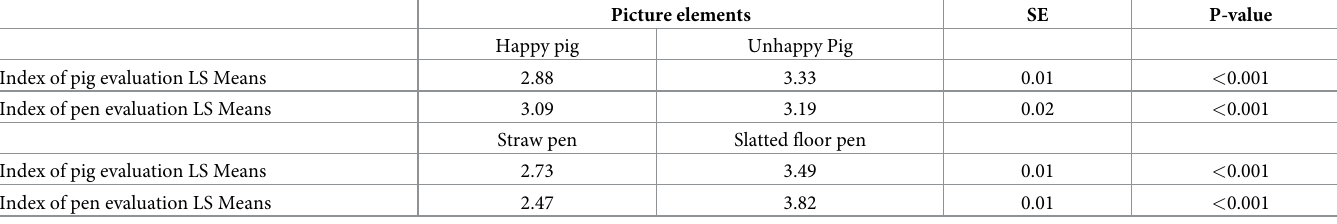
Table 8. Effects of pig and pen on pig and pen evaluation (1 = positive evaluation, 5 = negative evaluation) in the combined pictures showing a pig (‘happy’ or ‘unhappy’) in a pen (straw or slatted floor) using LS Means comparison with F-test. Picture elements